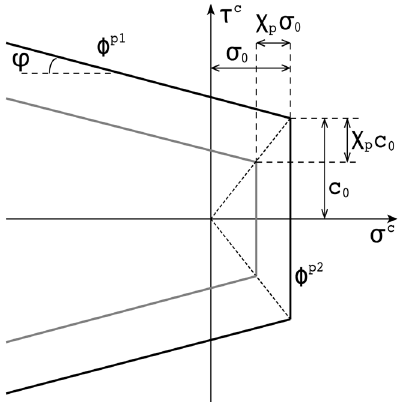
Figure 4: Bilinear plastic limit condition represented in the plane stress